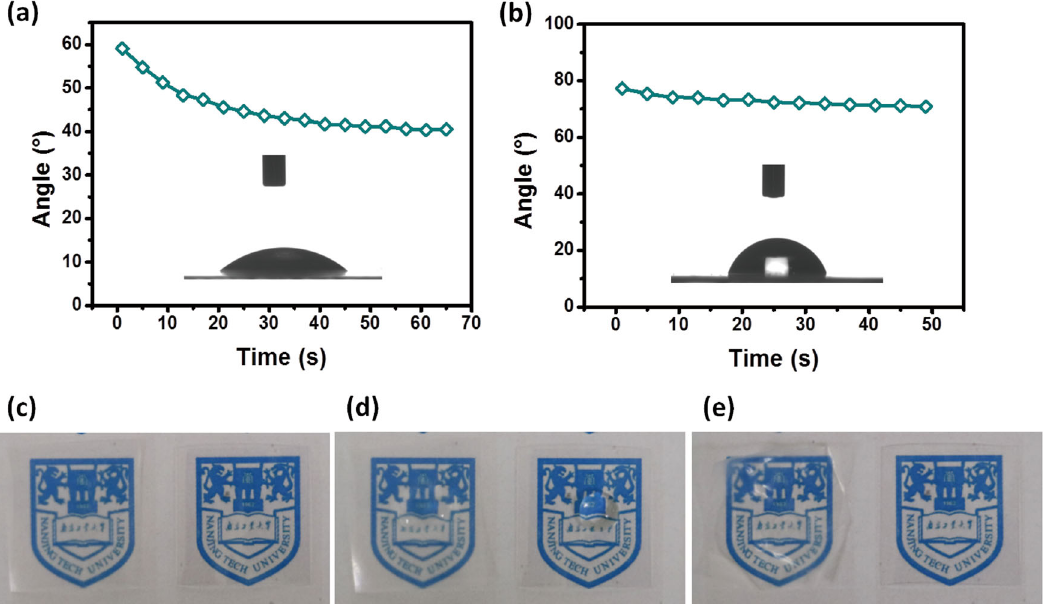
Fig. 2 Contact angle measurement and water-drop test. The contact angle measurement with water of a NCP and b NCP-based substrate with coating of acrylic resin. Digital photographs of (left) NCP and (right) NCP-based substrate c before dropping water, d after dropping water and e after drying